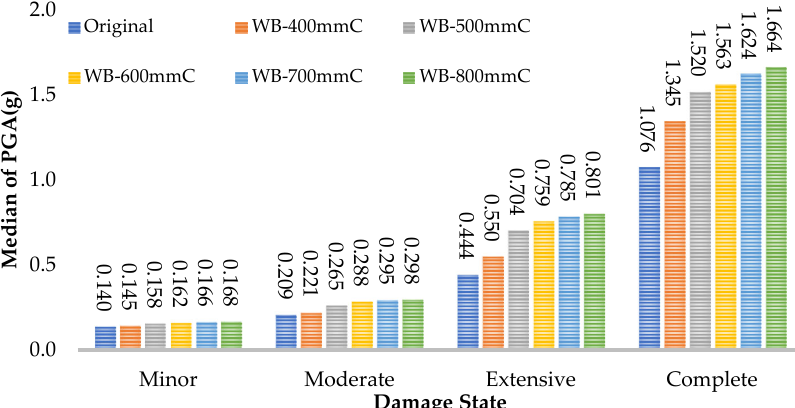
Figure 15. Improvement in the median of PGA in damage states in CFRP web ‐ bonding frames.